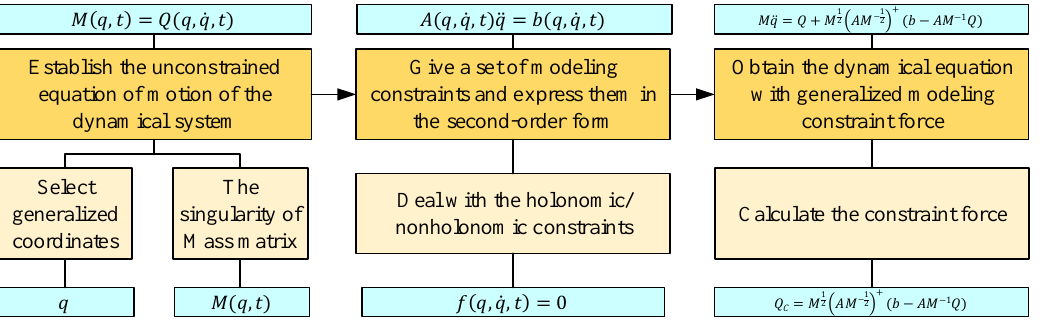
Figure 11. The three-step Udwadia-Kalaba modeling method.